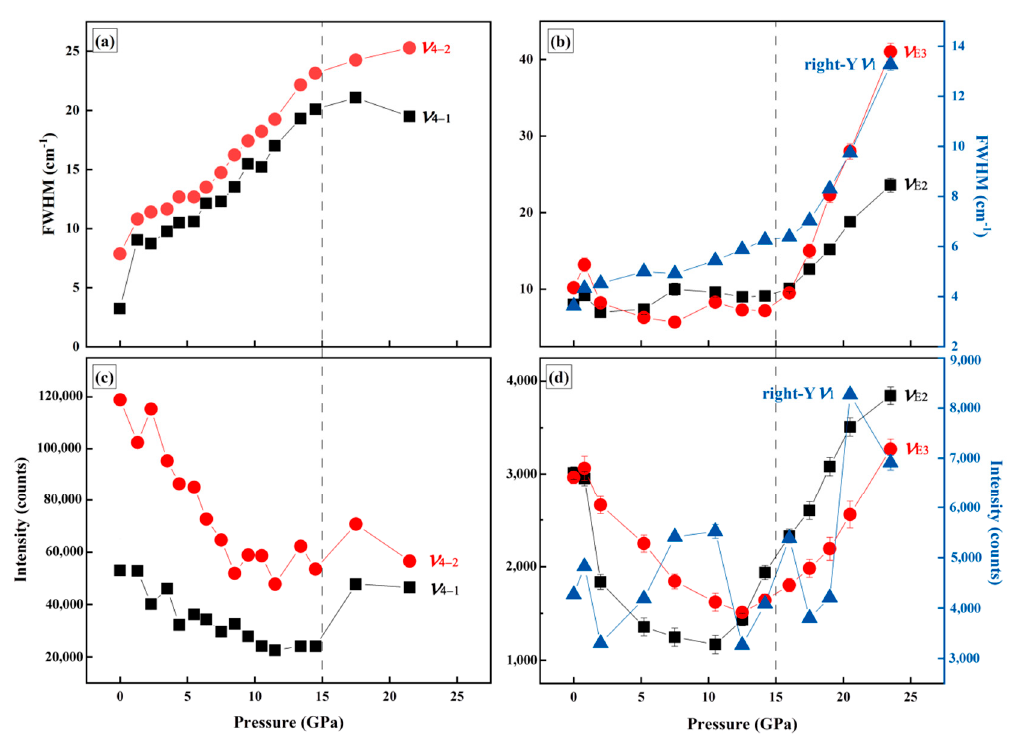
Figure 6. ( a , b ) FWHM and ( c , d ) intensity of selected IR or Raman modes of aragonite versus pressure with appropriate error bars shown.